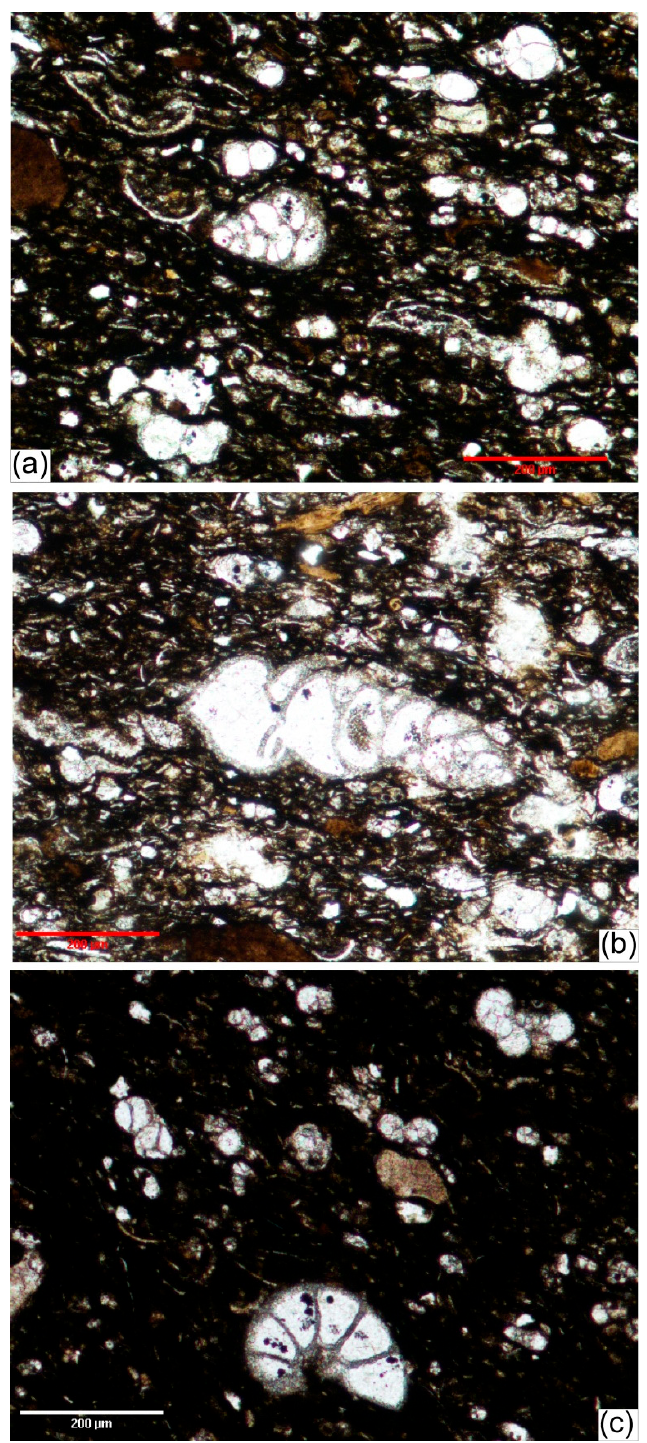
Figure 7. ( a ) and ( b ) Photomicrographs of organic matter-rich ferruginated mud hosting biserial calcareous benthic foraminifera and a few Ostracode carapaces, some of which terminate with a fishhook-like valve. ( c ) Wackestone (biomicrite) with planktonic (globigerinid) and multiple- ( c chambered benthic foraminifera.